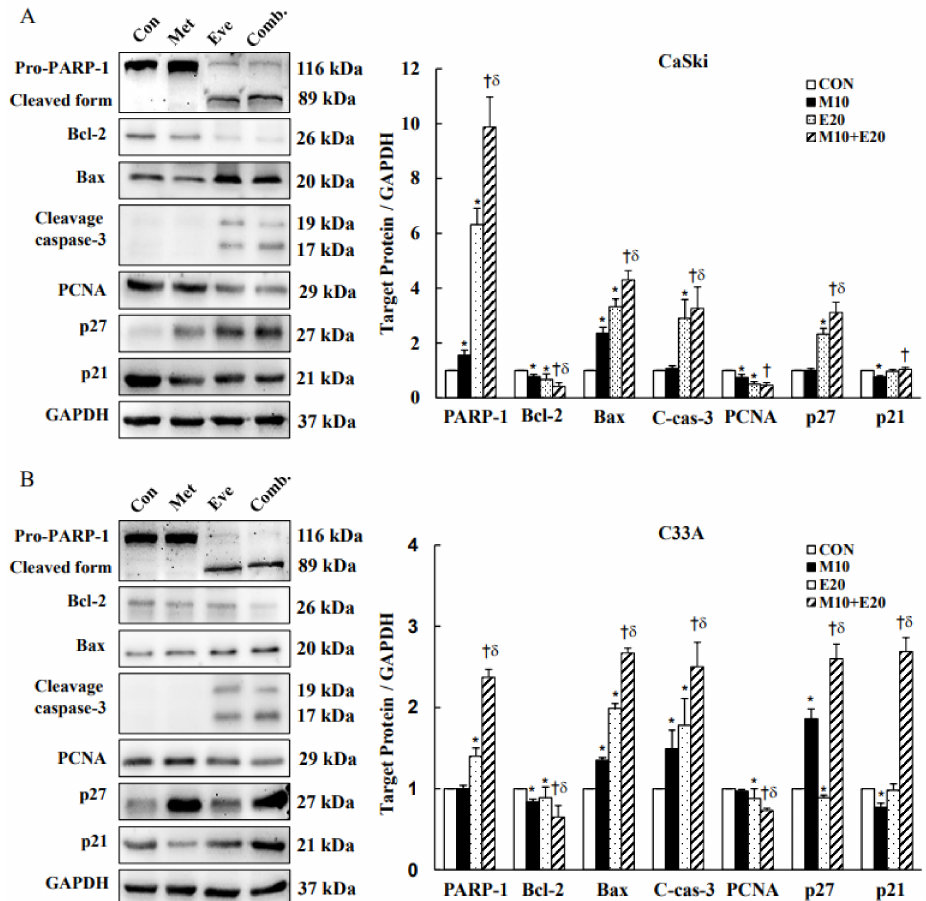
Figure 5. Metformin and everolimus induced apoptosis through mitochondrial and caspase-mediated pathways. Representative Western blot data showing expressions of apoptosis-related proteins in ( A ) CaSki and ( B ) C33A cells treated with metformin (10 mM) with or without everolimus (20 µ M) for 48 h. GAPDH served as the loading control. Quantitative results are presented in the bottom plot. Values represent the mean ± SD from three replicates. *, † and δ p < 0.05 compared with the CON, Met 10- or Eve 20-treated groups. CON, 0.1% DMSO; M10, 10 mM metformin; E20, 20 µ M